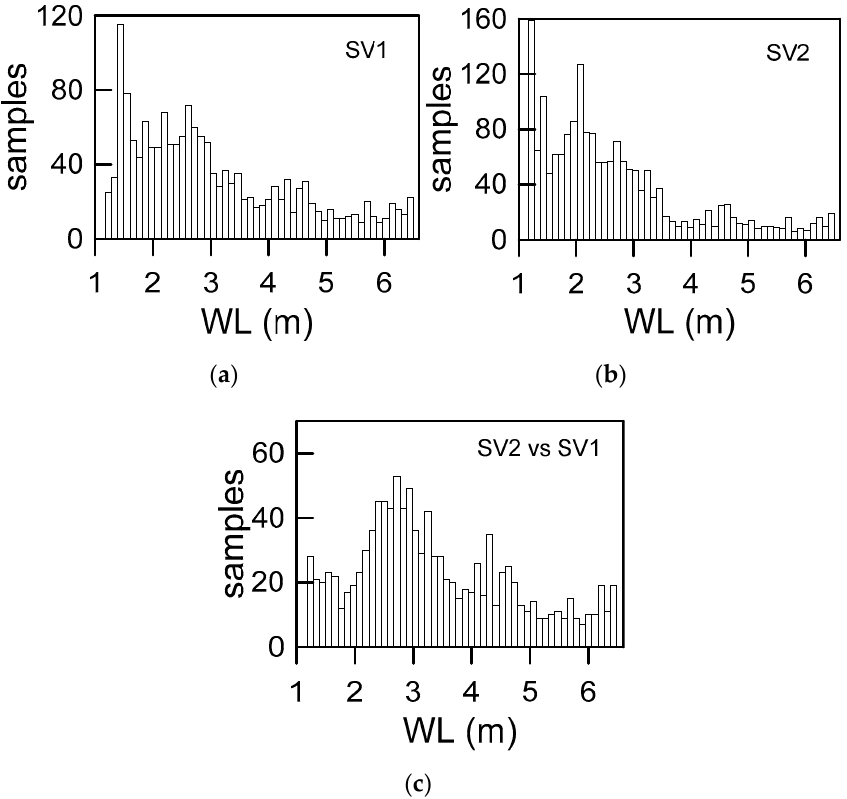
Figure 7. Data distribution related to WL at Wulilin Bridge: ( a ) SV1 vs. WL; ( b ) SV2 vs. WL; ( c ) SV2 vs. SV1.